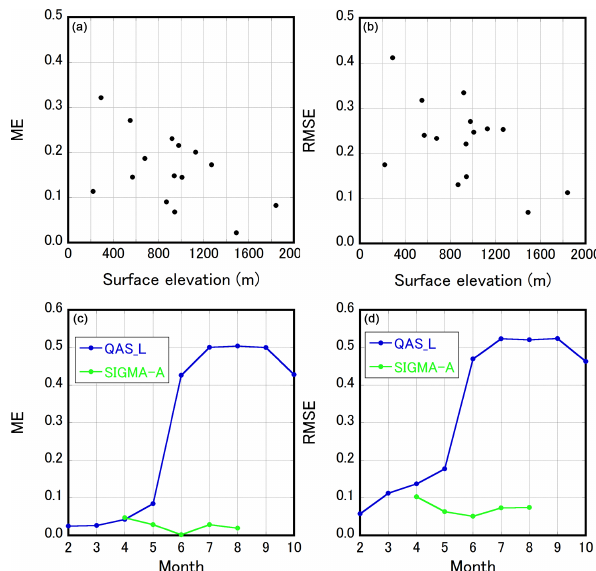
Figure 5. Evaluation of the hourly snow/firn/ice albedo simulated at each AWS (Fig. 1 and Table S7). (a) Mean error (ME) and (b) root mean square error (RMSE) as a function of surface el- evation. (c) Monthly changes in ME and (d) monthly changes in RMSE for simulated snow/firn/ice albedo at QAS_L (blue line) and SIGMA-A (green line) during months in which the sun appears at each